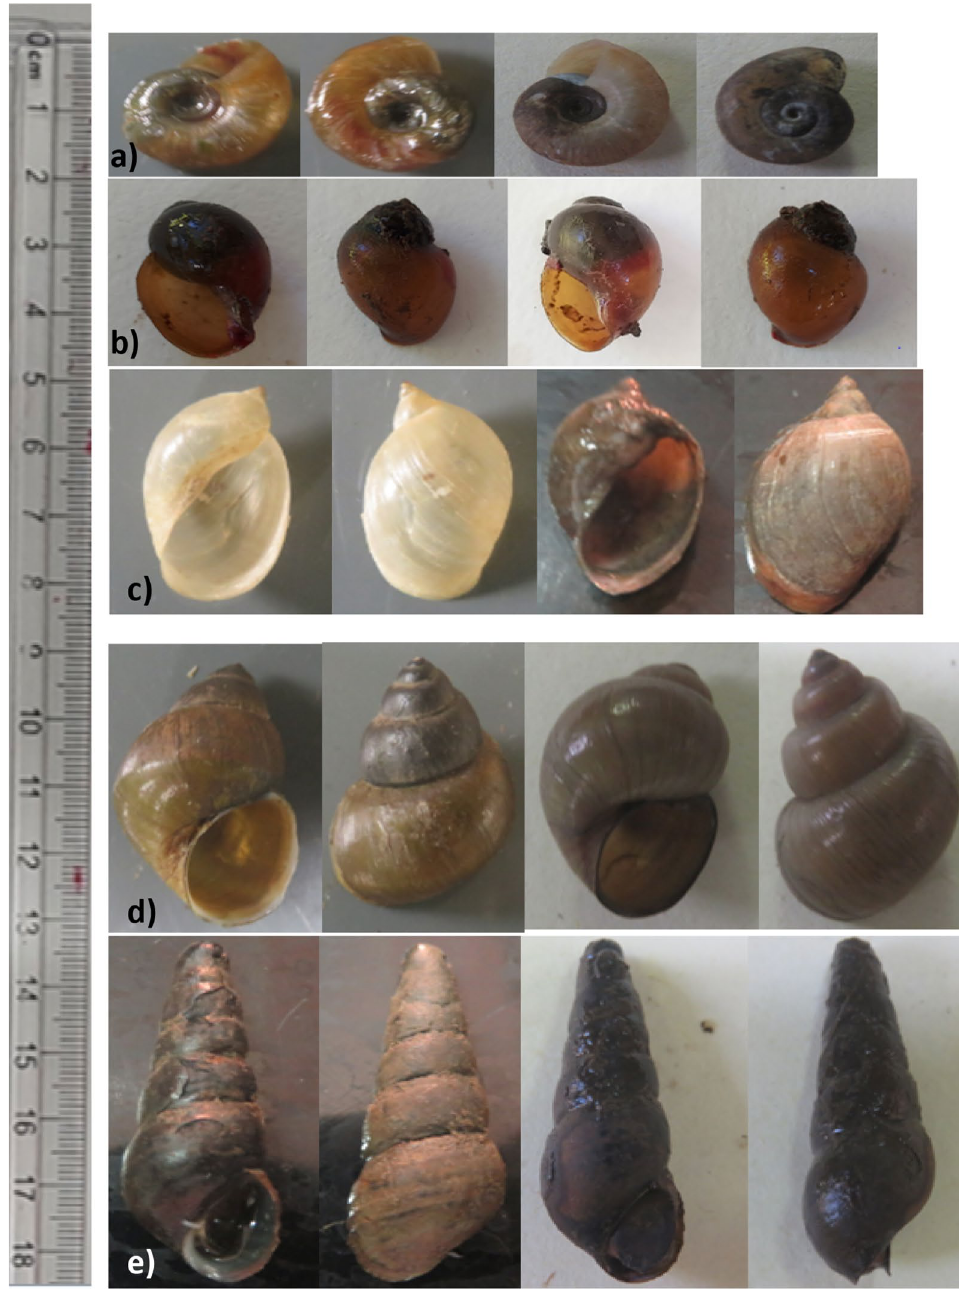
Figure 3. Freshwater snail genera collected from Lake Tana; ( a ) Biomphalaria snails (right and left side view), ( b ) Bulinus snails (apertural and abapertural view), ( c ) Lymnaea snails (ventral and dorsal view), ( d ) Bellamya snails (ventral and dorsal view) and ( e ) Melanoides snails (ventral and dorsal view). All the images were taken by the corresponding author